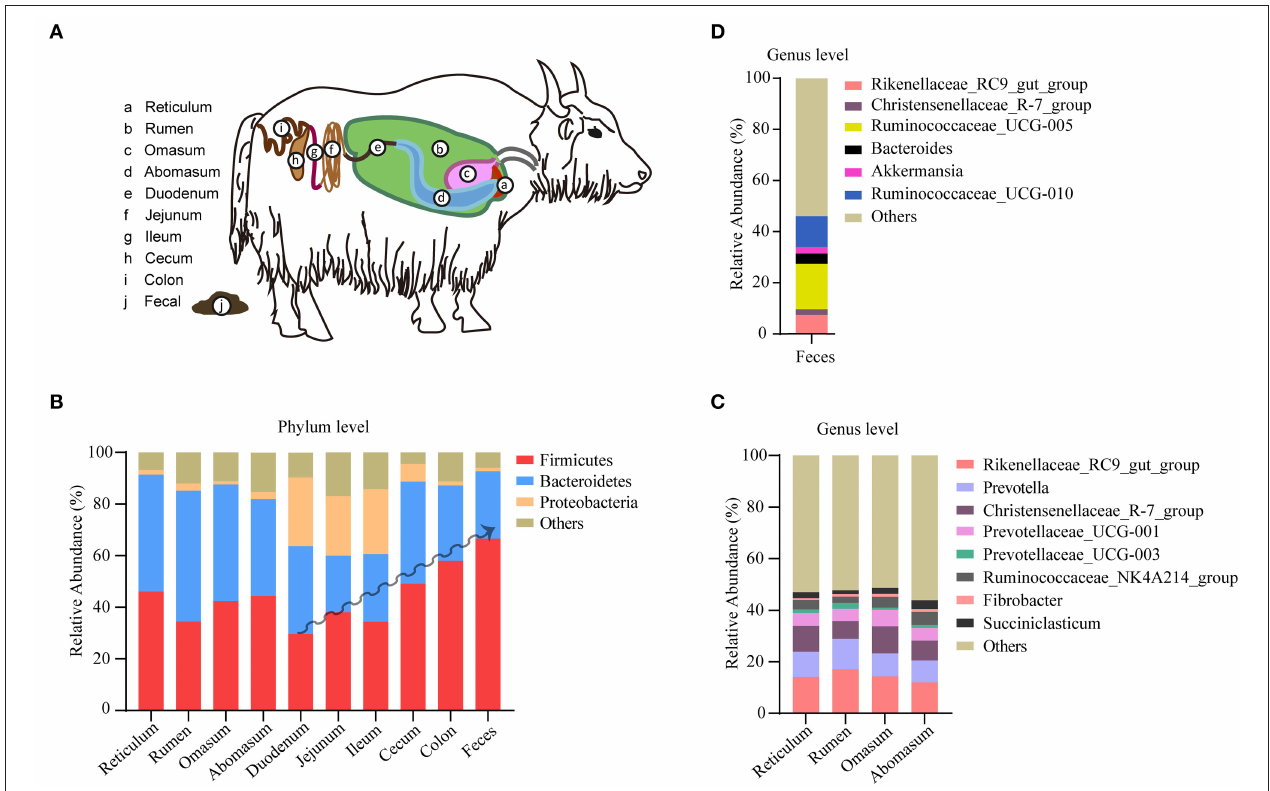
FIGURE 2 | Microbiota distribution in different segments of yak digestive tract. (A) Overview of the segmented yak gastrointestinal system. (B) The composition of microbiota at phylum level in reticulum ( n = 9), rumen ( n = 481), omasum ( n = 9), abomasum ( n = 9), duodenum ( n = 9), jejunum ( n = 9), ileum ( n = 9), cecum ( n = 9), colon ( n = 21), and feces ( n = 417). (C) The composition of microbiota at genus level in rumen ( n = 129), omasum ( n = 9), reticulum ( n = 9), and abomasum ( n = 9). (D) The composition of microbiota at genus level in yak feces ( n = 98). The relative abundance of each taxa was expressed as